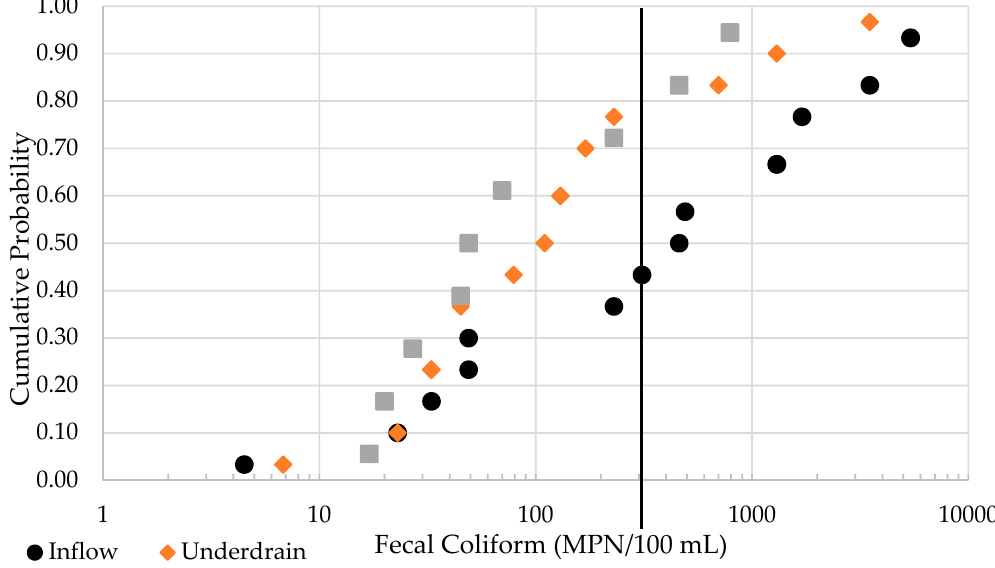
Figure 7. Fecal coliform probability plot with water quality standard of 200 MPN/100 mL. Table 6. Summary of studies reporting bacteria and sediment concentration reductions from SCMs.